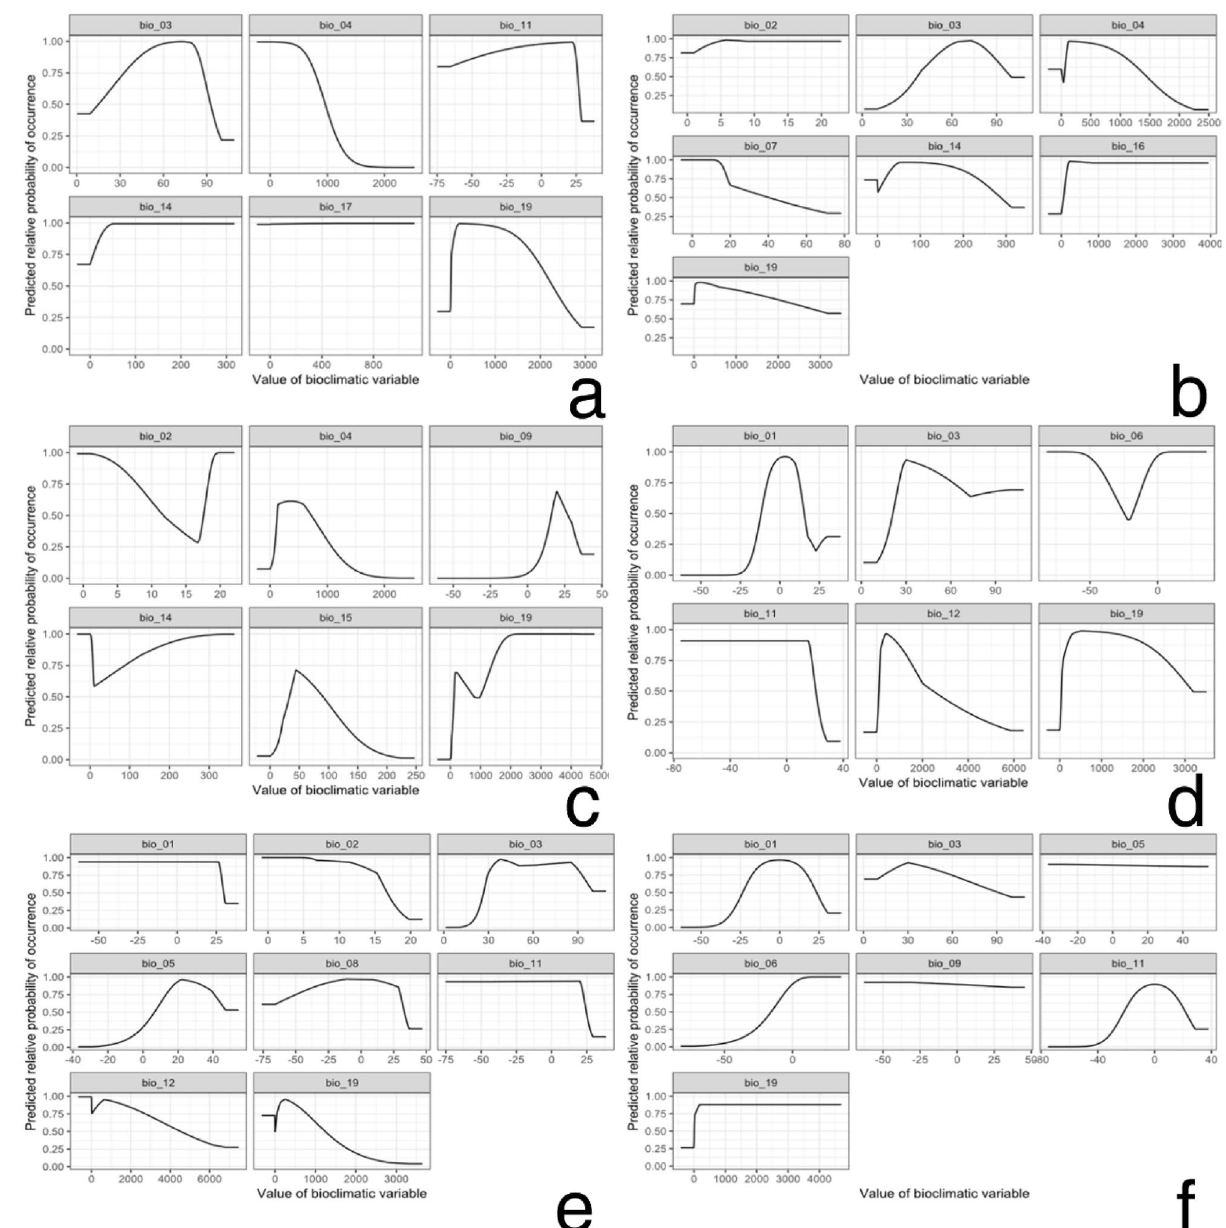
Figure 11. Response curves for selected variables of six important quarantine species: ( a ) Crenidorsum aroidephagus , ( b ) Aleurothrixus trachoides , ( c ) Paraleyrodes minei , ( d ) Nasonovia ribisnigri , ( e ) Macrosiphum euphorbiae , ( f ) Viteus vitifoliae. Figures were created using R version 4.04 (https:// www.r- proje ct.